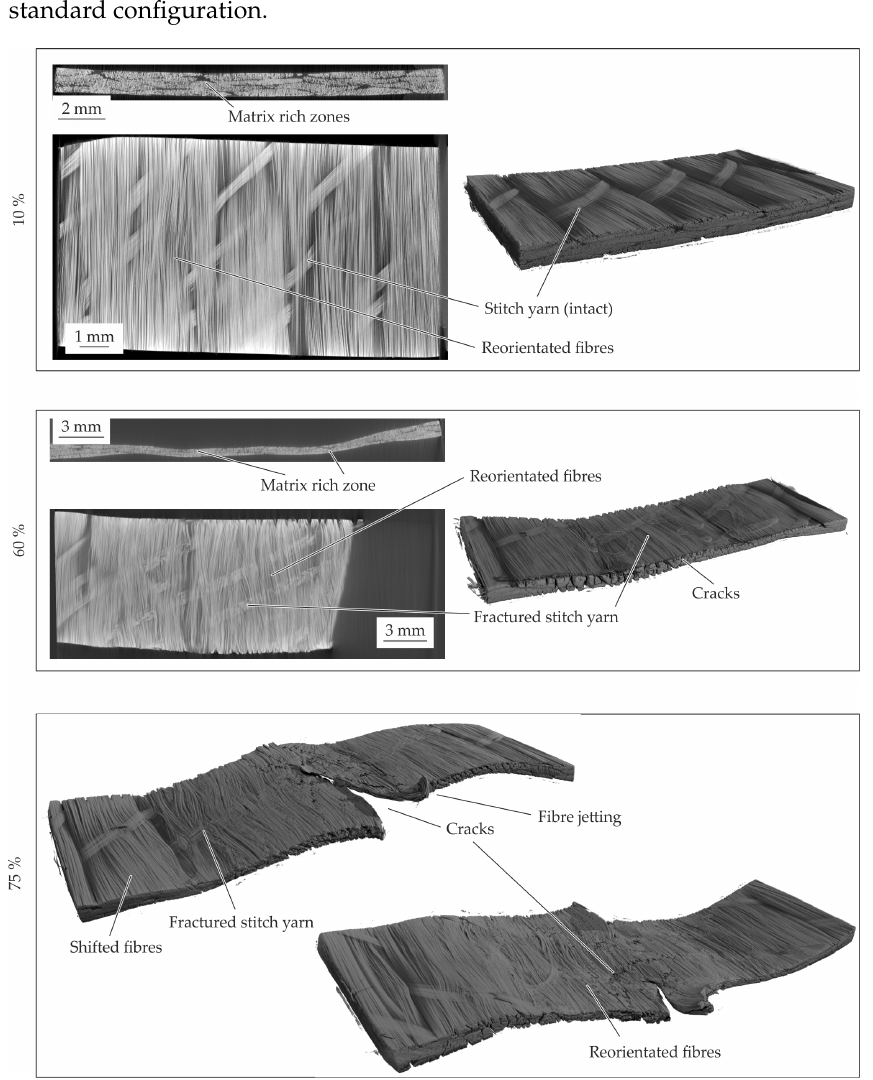
Figure 15. CT analysis of the 1mm–configuration for the different compaction levels at